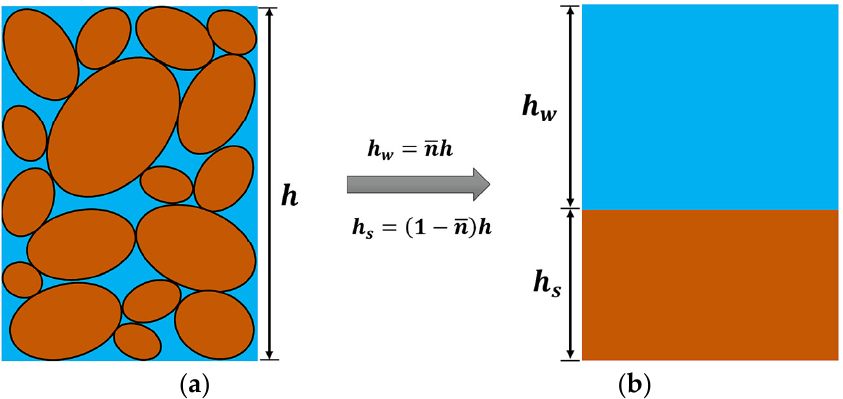
Figure 1. Scheme for obtaining partial heights of both phases. h s and h w are the partial heights corresponding to the solid and fluid